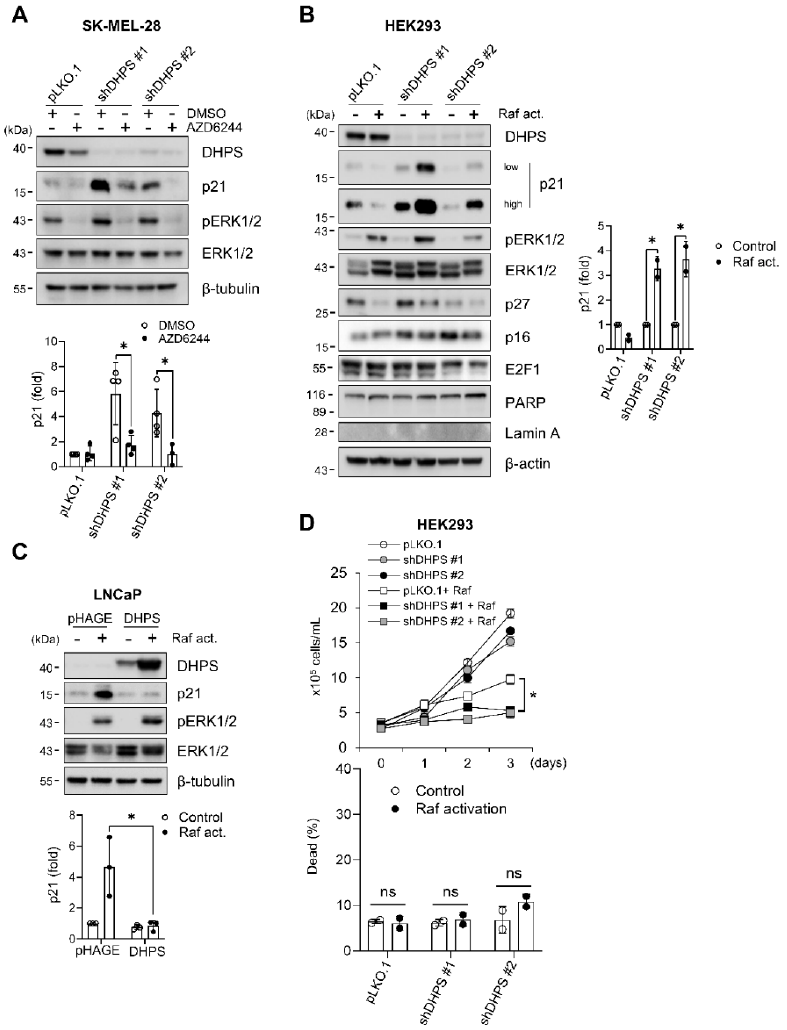
Figure 5. Raf/MEK/ERK activity is necessary for DHPS depletion to increase p21 CIP1 levels. ( A ) Western blots of total lysates of cells infected with pLKO.1 ‐ shDHPS viruses for 4 days, and then treated with 100 nM AZD6244 for an additional 24 h. Equal volume DMSO was used as a vehicle control. (bottom) Densitometry of p21 CIP1 normalized to β‐ tubulin. ( B ) Western blots of total lysates of HEK293 ‐Δ Raf:ER cells infected with pLKO.1 ‐ shDHPS for 5 days and then treated with 1 μ M tamoxifen for an additional 24 h (Raf act.). (right) Densitometry of p21 CIP1 normalized to β‐ actin. ( C ) Western blots of total lysates of LNCaP ‐Δ Raf:ER cells infected with pHAGE ‐ DHPS virus for 48 h and treated with 1 μ M tamoxifen for an additional 24 h (Raf act.). (bottom) Densitometry of p21 CIP1 normalized to β‐ tubulin. ( D ) Trypan blue exclusion assays to determine viability of HEK293 ‐Δ Raf:ER cells treated as described in ( B ). Cell death was determined at day 3. Data are mean ± SD of biological triplicate and duplicate. * p < 0.05 by two ‐ tailed Student t ‐ test. 2.6. DHPS Knockdown Increases CDKN1A Transcription via TP53 and SP1 in A375 and SK ‐ MEL ‐ 28 Cells